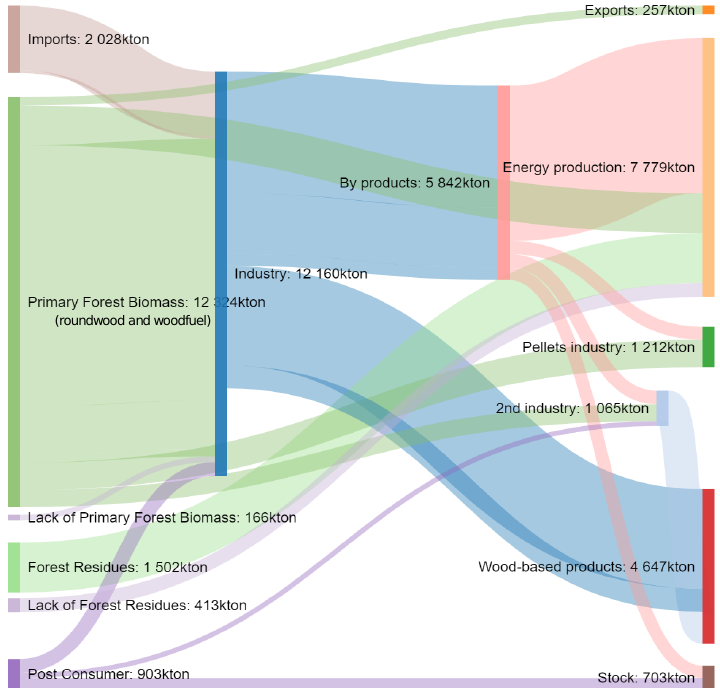
Figure 5. Sankey diagram driven by the scenario analyses applied for the Portuguese case.